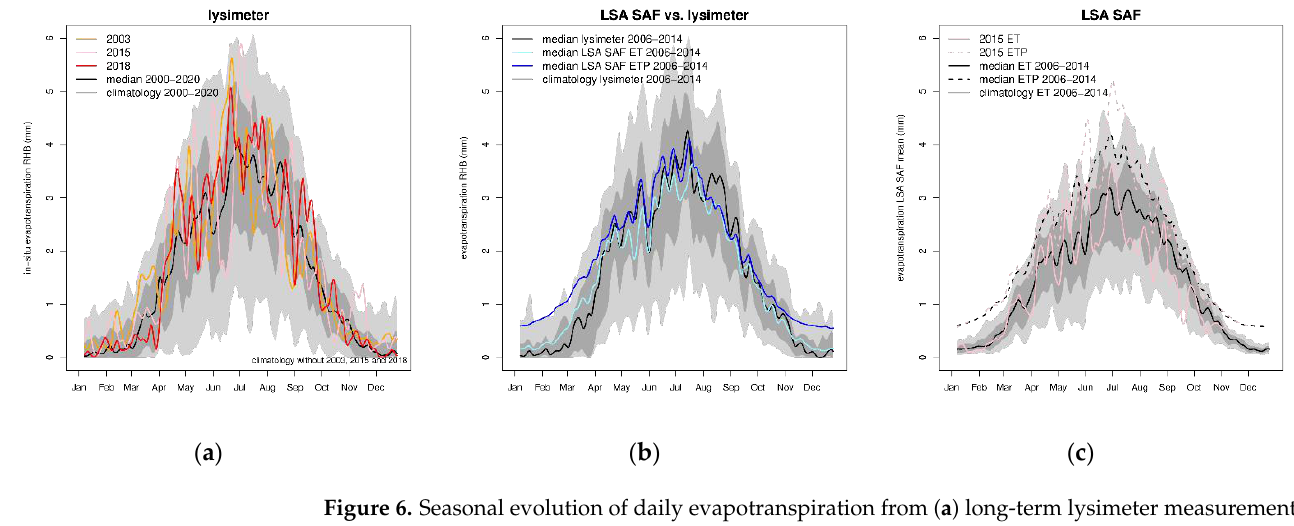
Figure 6. Seasonal evolution of daily evapotranspiration from ( a ) long-term lysimeter measurements at the Rietholzbach site from 2000 to 2020, ( b ) lysimeter measurements and satellite-based data at the Rietholzbach site from 2006 to 2014, and ( c ) spatially-aggregated satellite-based data from 2006 to 2014 (based on the grid cells closest to the ten considered grassland stations). The dark grey shading shows the 25% – 75% range of the respective background climatology; the light grey shading shows the 5 – 95% range. The evolution of the respective median as well as of the covered dry years is highlighted.